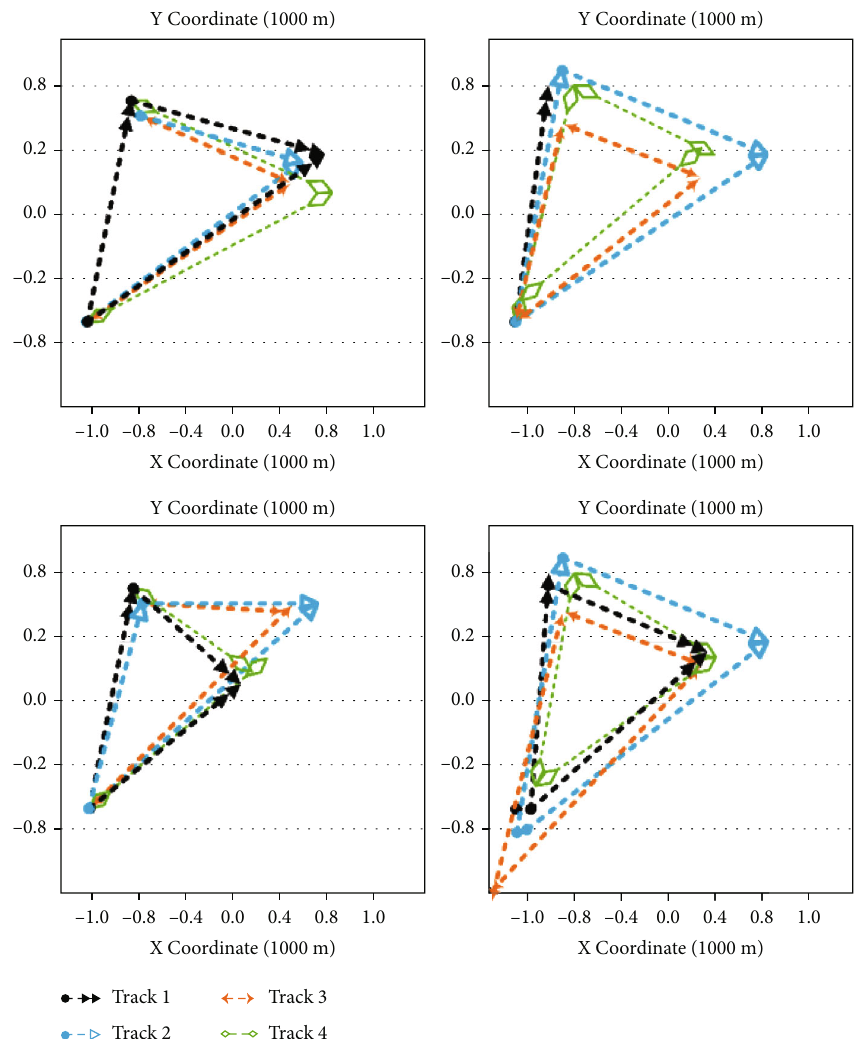
Figure 8: Path planning data diagram of actual task simulation feedback.